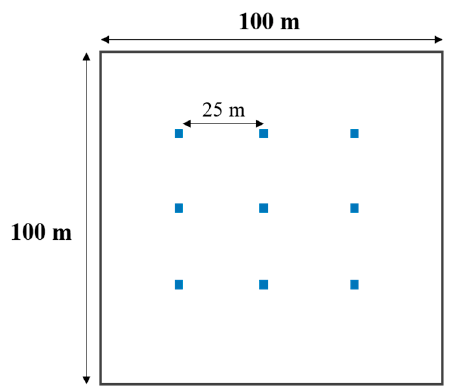
Figure 2. Schematic of the field sampling procedure. The nine squares represent the 1 m 2 subplots distributed in the 1 ha plots.